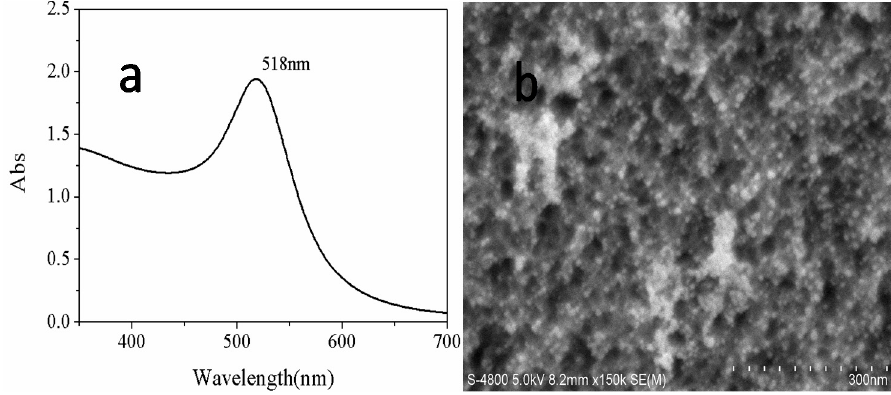
Figure 4. ( a ) The UV-Vis spectra of Au NPs, and ( b ) surface morphology of PSiMC after deposition of Au NPs.